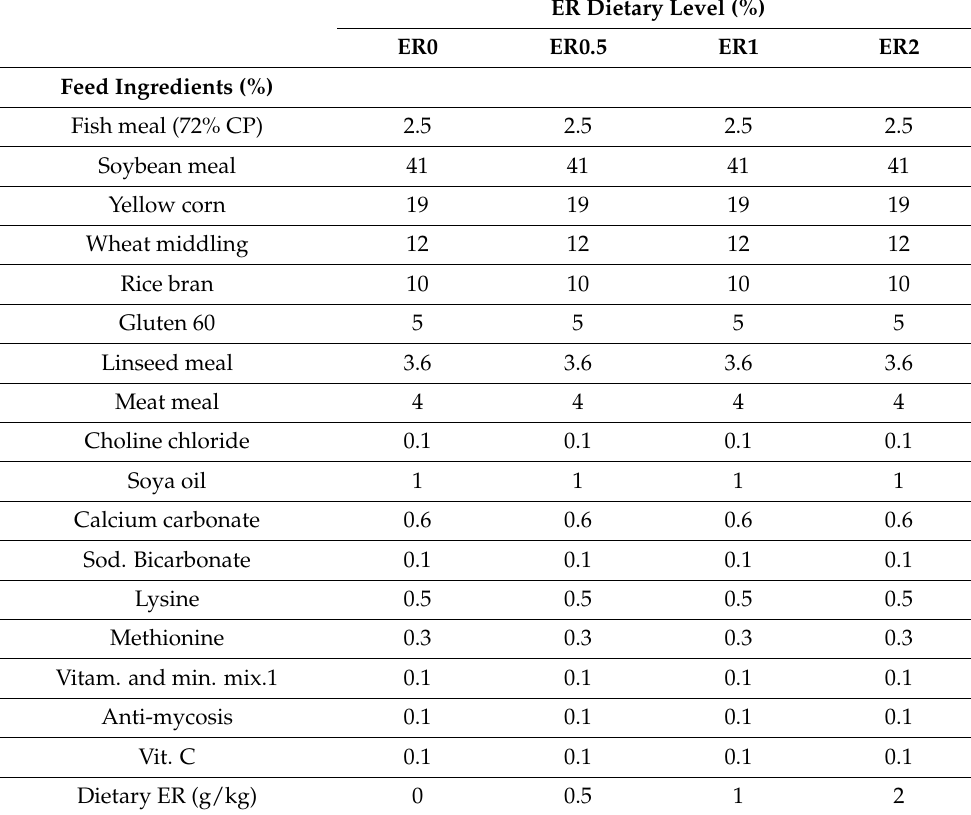
Table 1. Chemical composition of the